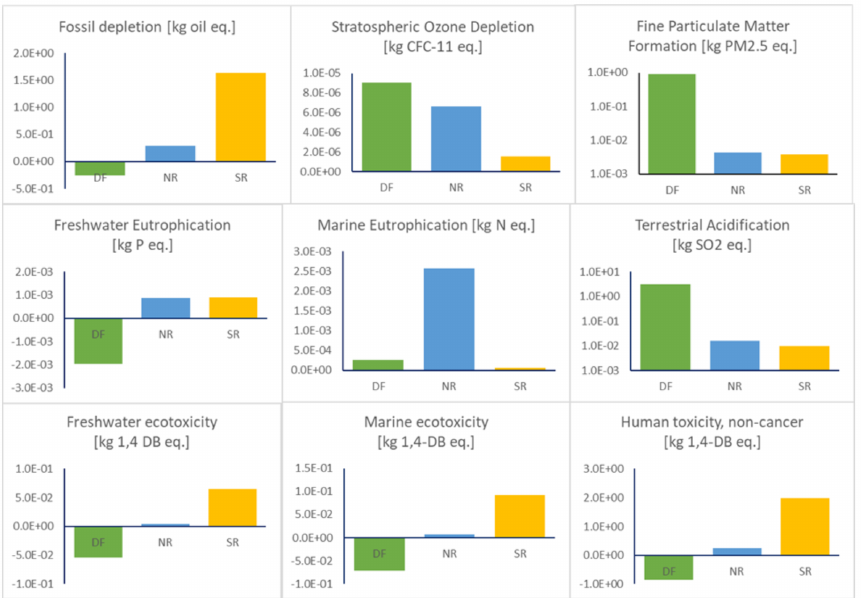
Figure 5. Life cycle environmental impacts of producing 1 kg of polyisoprene using ReCiPe 2016 midpoint impacts. The impacts for fine particular matter and terrestrial acidification are given in log scale on the